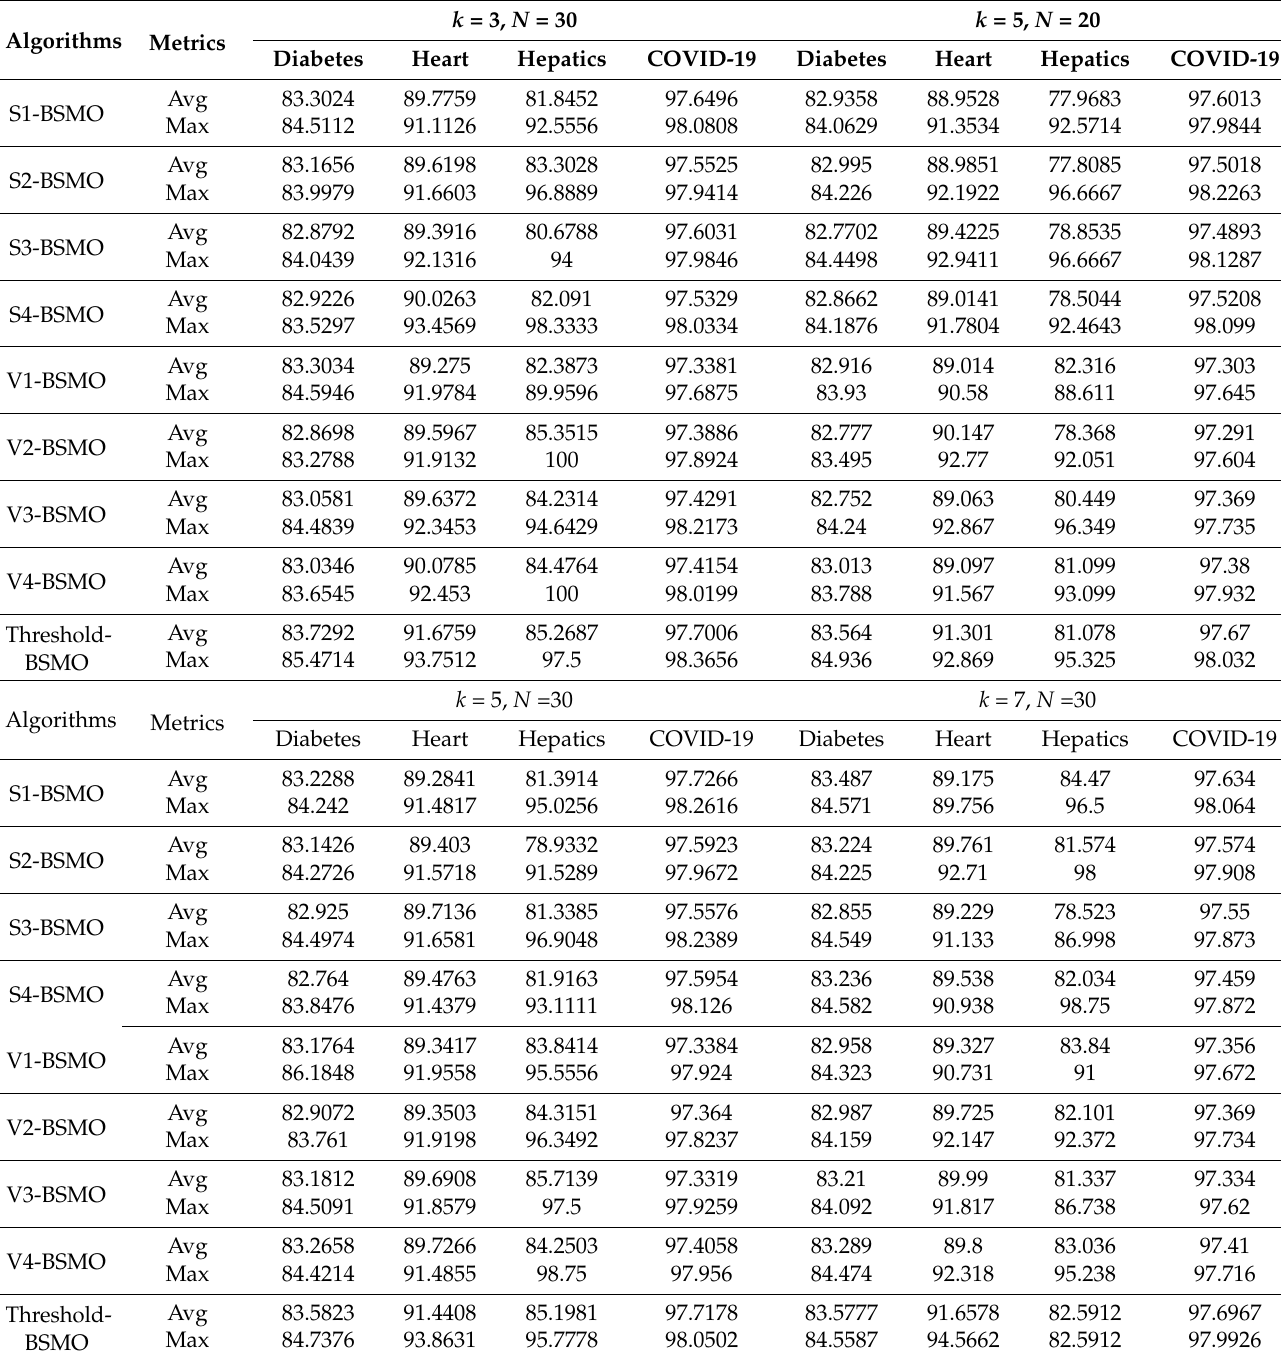
Table A5. Parameters setting of BSMO algorithm in terms of precision